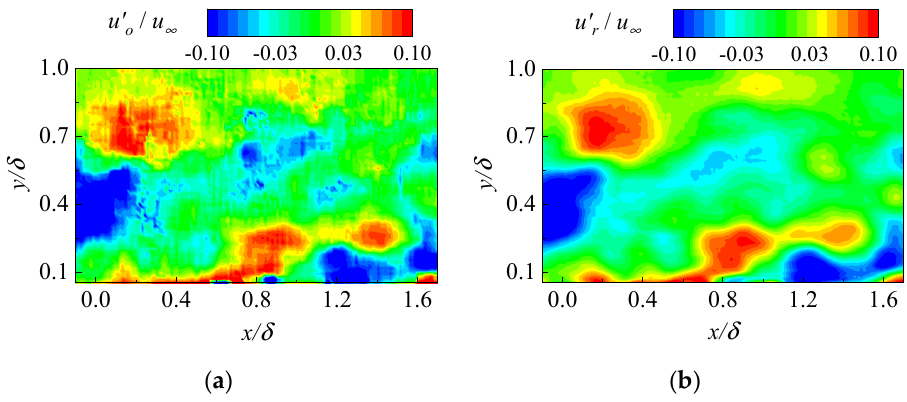
Figure 15. Comparison of ( a ) original and ( b ) reconstructed fluid field. Figure 16 manifests the relative probability statistics of the dimensionless large-scale